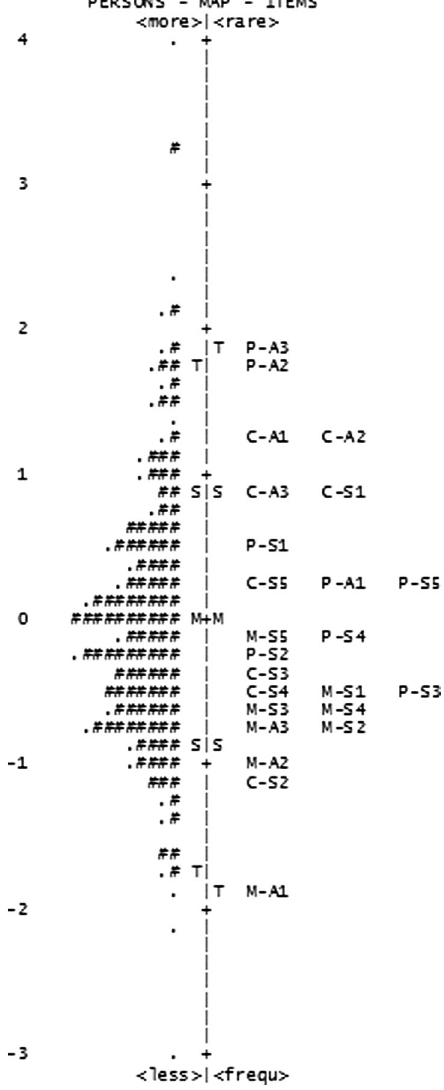
FIG. 2. Item-person map. M denotes the mean of each distri- bution; S denotes 1 standard deviation, and T 2 standard devia- tions from the mean. Each ‘‘#’’ represents 3 students and each ‘‘.’’ less than 3